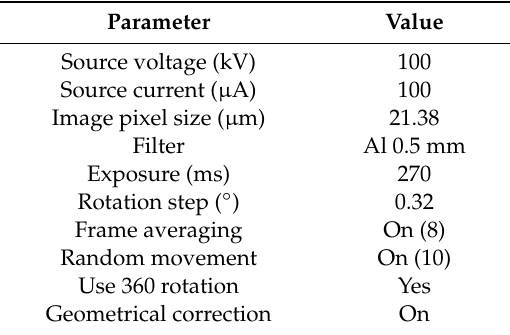
Table 3. Selected, more important scanning parameters.